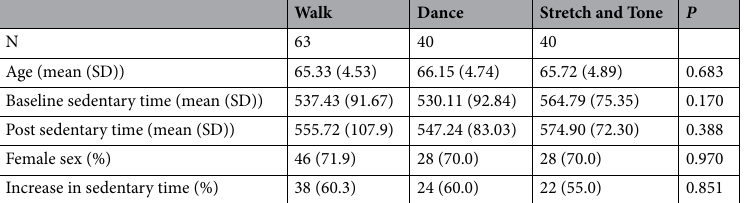
Table 1. Participant characteristics. Baseline sedentary time = estimated baseline average daily minutes spent sedentary, Post sedentary time = estimated post-intervention average daily minutes spent sedentary. P-value represents the results of ANOVA (continuous) or chi-square test of independence (categorical) tests on outcome and demographic variables between